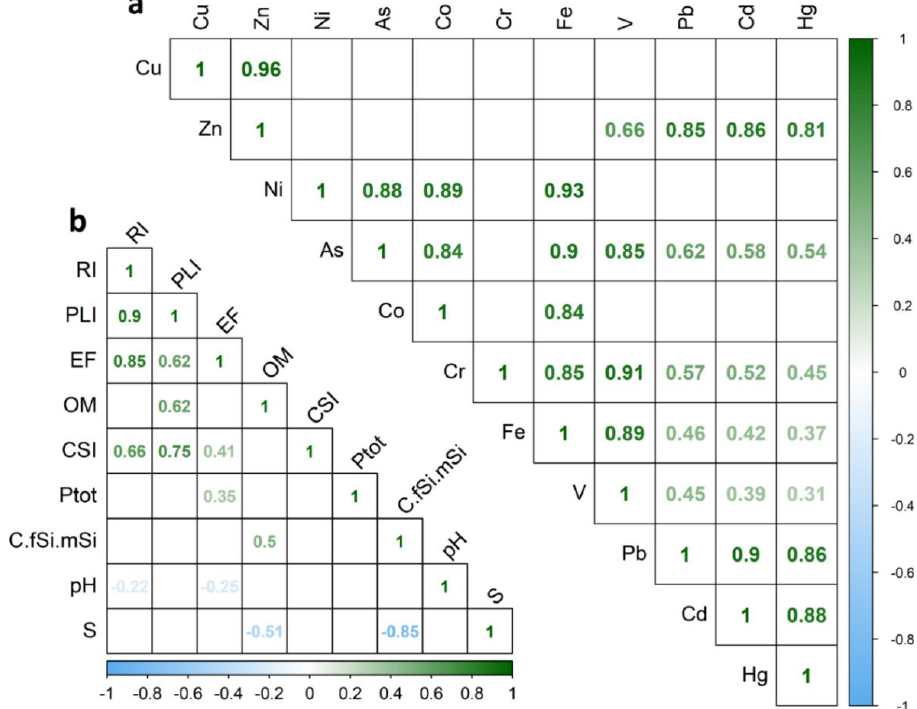
Figure 5. Spearman correlation matrix in first principal component order ( n = 110, insignificant values